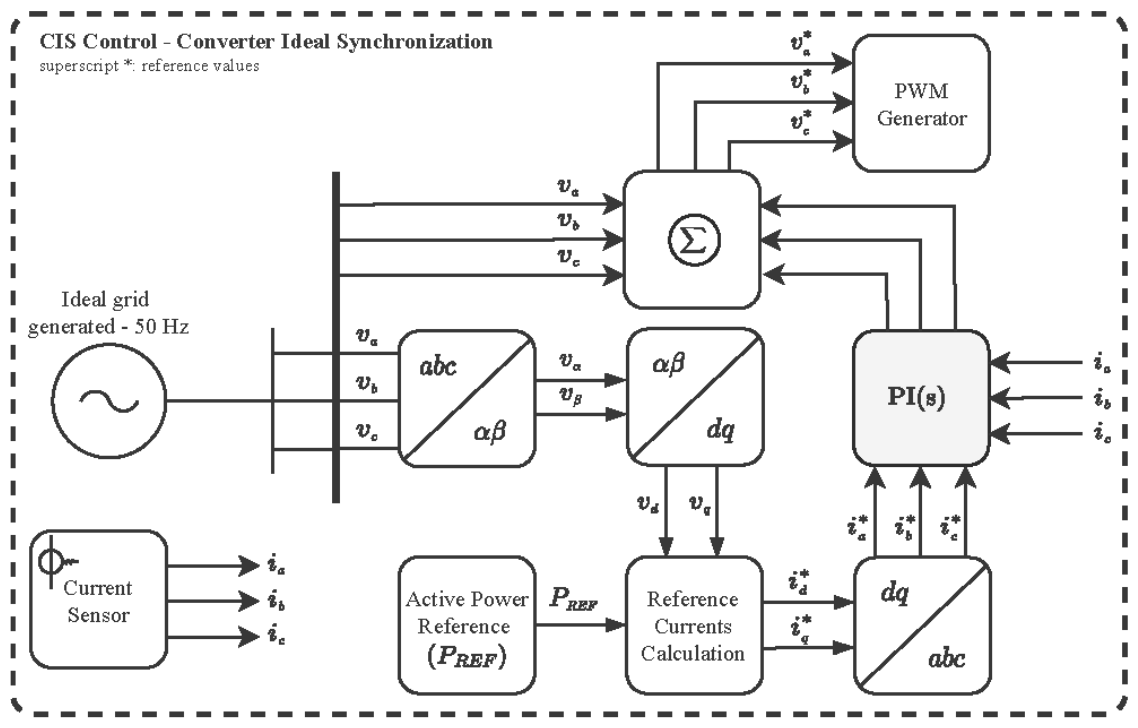
Figure 5. Black Start Non-Linear Control Diagram (CIS).